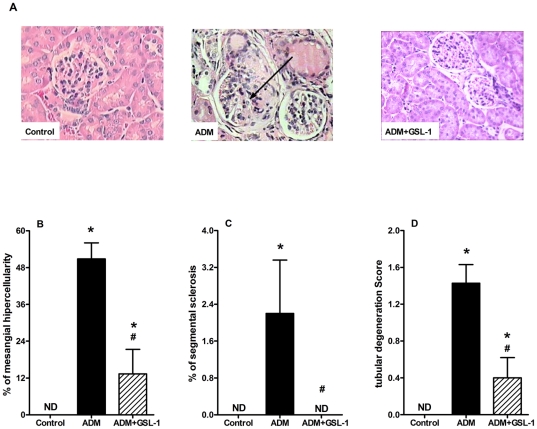
GSL-1 treatment inhibits renal injury due to ADM cytotoxicity.BALB/c mice were injected at day 0 with 10 mg/kg of adriamycin (ADM) or treated concomitantly with ADM and 5 µg/mouse GSL-1 (ADM+GSL-1). (A) Representative image of the renal alterations induced by ADM administration (black arrow). Figures B to D show graphic representation of the mesangial hypercellularity, signs of glomerular sclerosis and tubular degeneration induced by ADM administration. Figure 2 corroborates the renoprotective effect of GSL-1 treatment depicted in Figure 1. * p<0.05 vs. control; # p<0.05 vs. ADM.